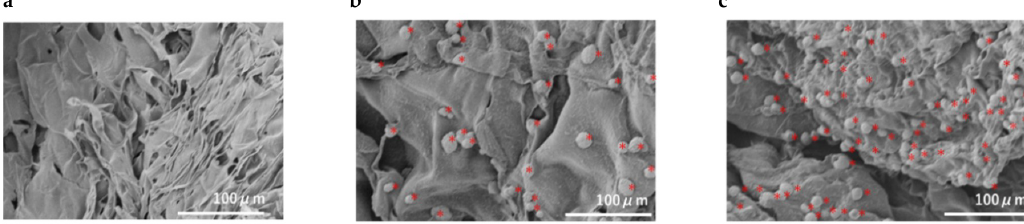
Figure 3. Scanning electron microscopy image. Low and high magnification of SEM images in which the cells were seeded in a gelatin sponge (GS) and cultured for 3 days. The rat dedifferentiated adipocytes (rDFATs) attached to the sponges. ( a ) Cell‐free GS, ( b ) GS seeded with rDFATs, ( c ) GS with activated platelet‐rich plasma added to rDFATs. Red asterisks show cells.